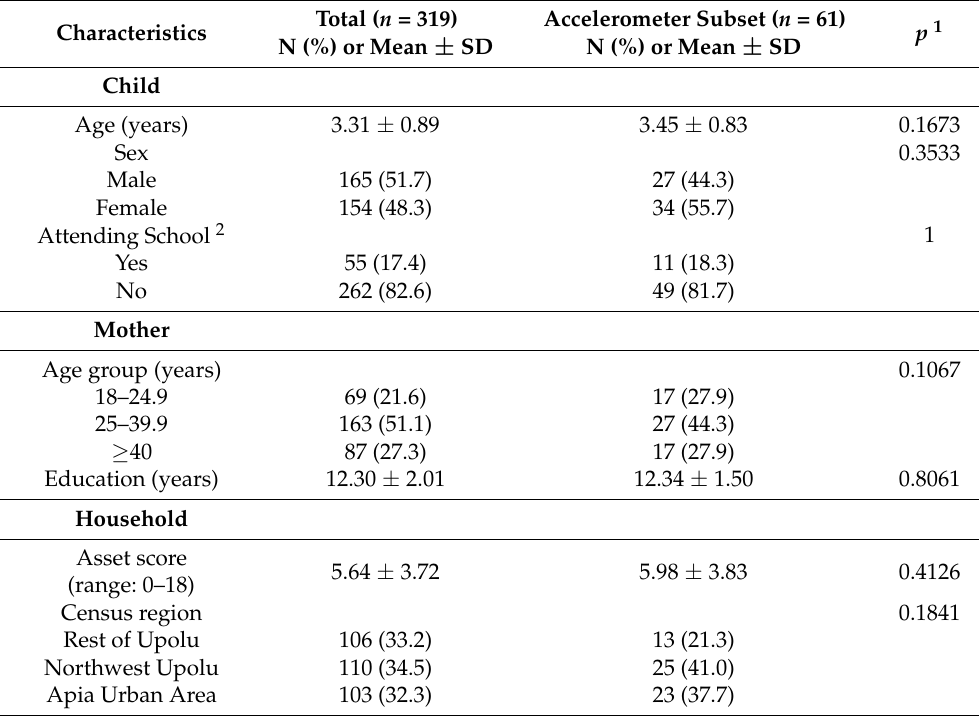
Table 1. Child, mother and household characteristics by total sample and accelerometer subset.